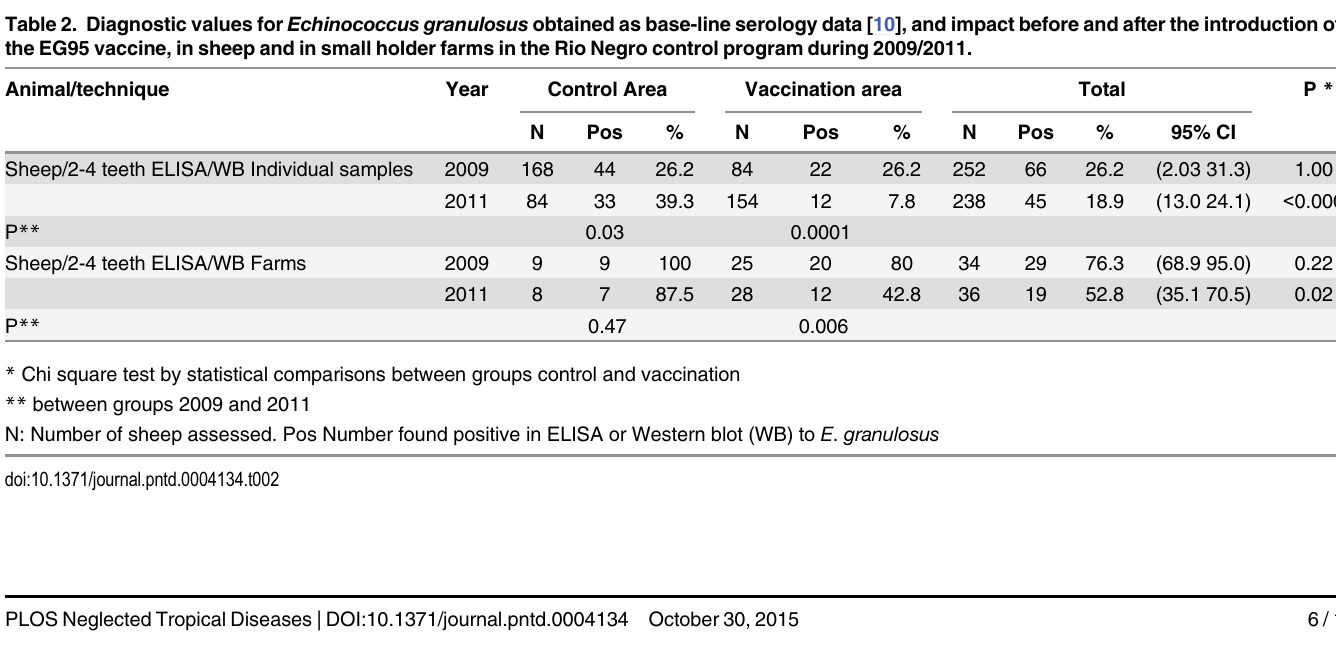
Table 2. Diagnostic values for Echinococcus granulosus obtained as base-line serology data [10], and impact before and after the introduction of the EG95 vaccine, in sheep and in small holder farms in the Rio Negro control program during 2009/2011. Animal/technique